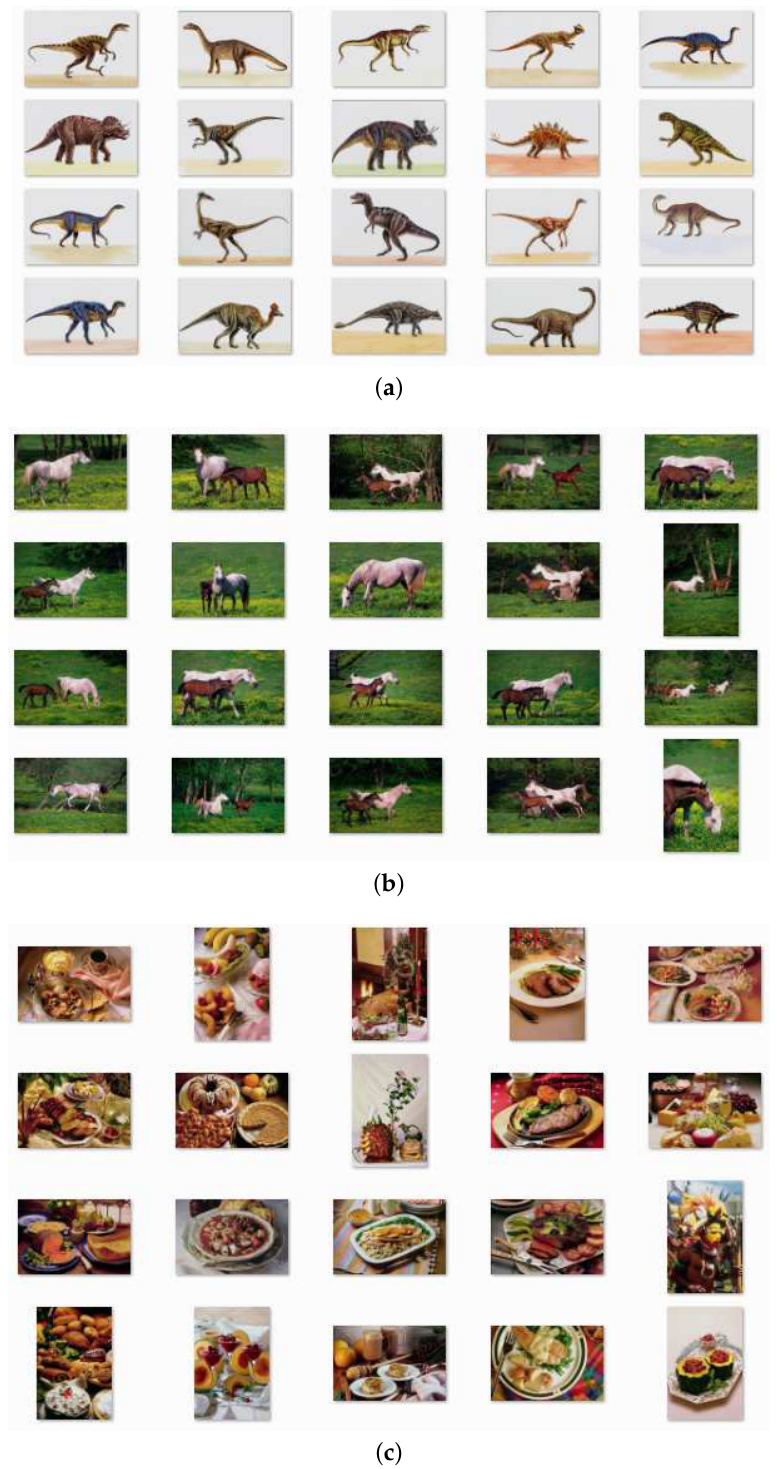
Figure 6. Retrieved images for the Top 20: the dinosaurs category ( a ); ( b ) the horses category; and ( c ) the foods category. The query image is the first image in each